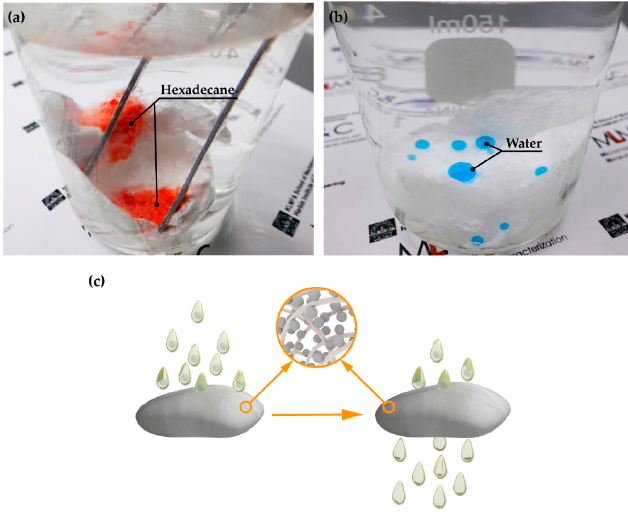
Figure 4. ( a ) Hexadecane (dyed red) spread and permeated the cotton in a water environment. ( b ) The superhydrophobic behavior of the treated cotton in an oil ( n -dodecane) environment. ( c ) Schematic illustration of the demulsification mechanism of a water-in-oil emulsion.